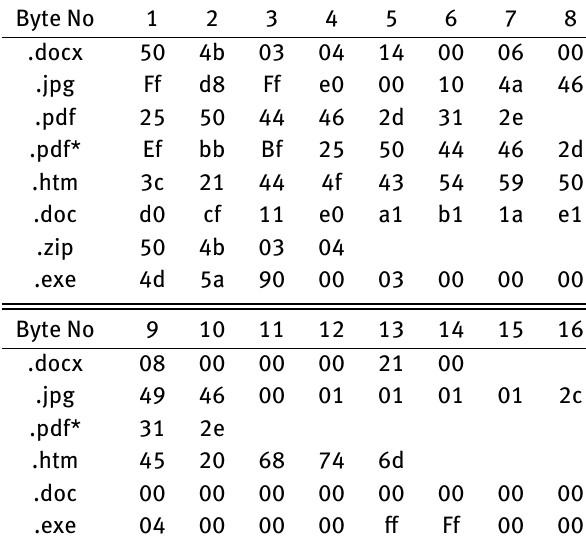
Table 2: Number of tries for irreducible polynomials versus key length.